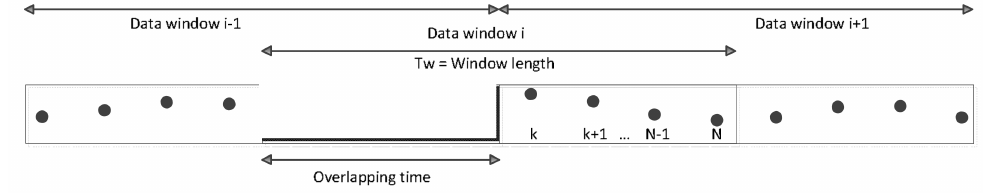
Figure 5. Each data window consists of N signal values. Two consecutive data windows overlap each other by an overlapping ratio of